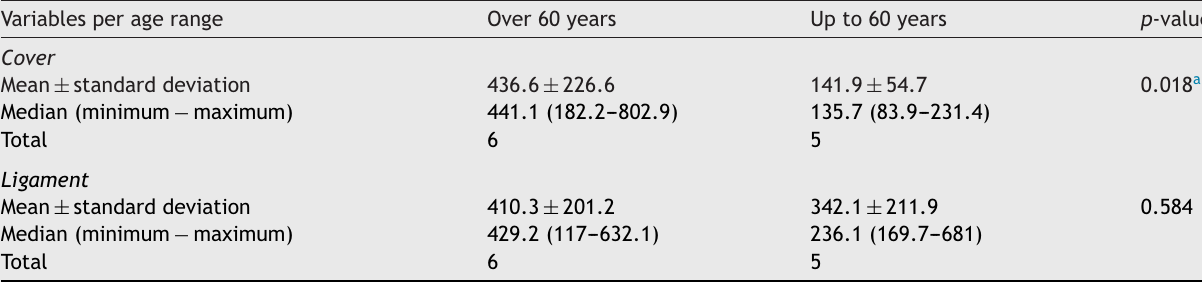
GAG concentration according to the age range in: cover and ligament.